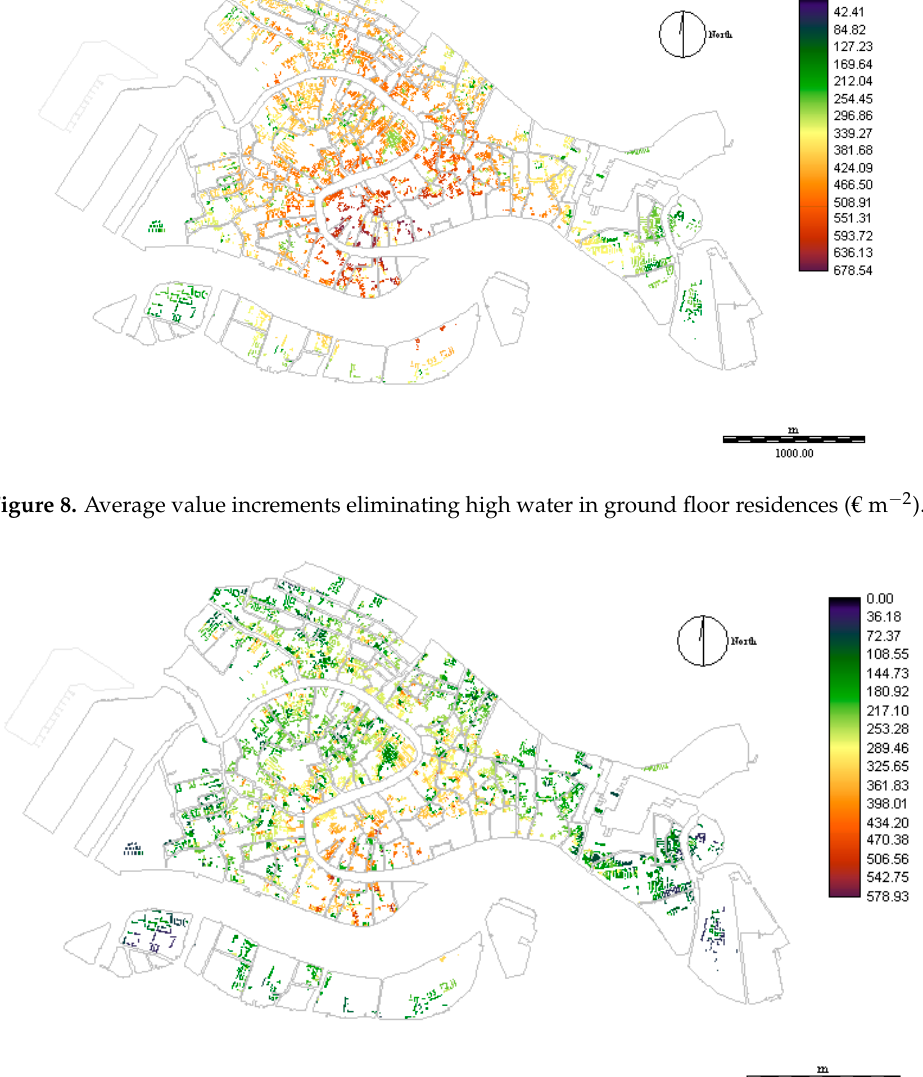
Figure 8. Average value increments eliminating high water in ground floor residences (€ m − 2 ). Table 7. Average value increments for the Sestiere (€ m − 2 ).